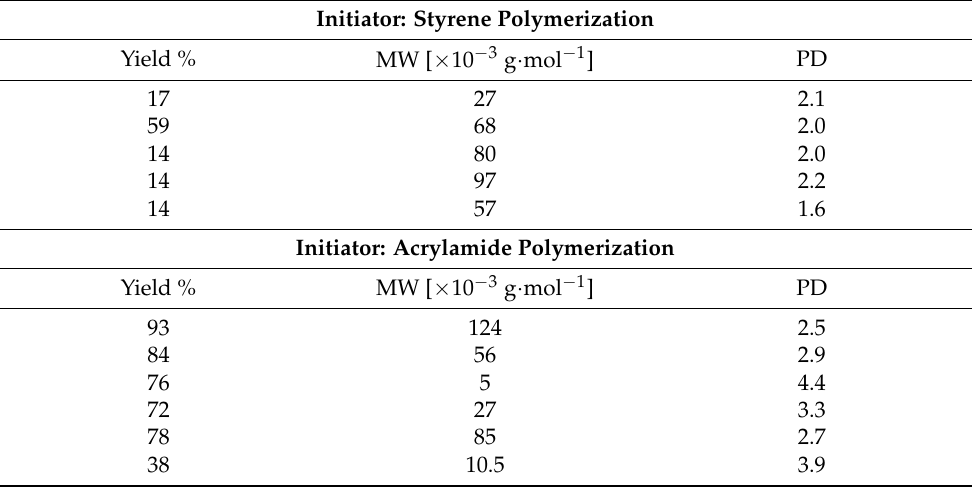
Table 6. Yields, MW, and PD from acrylamide and styrene polymerization as initiators [76]. Initiator: Styrene